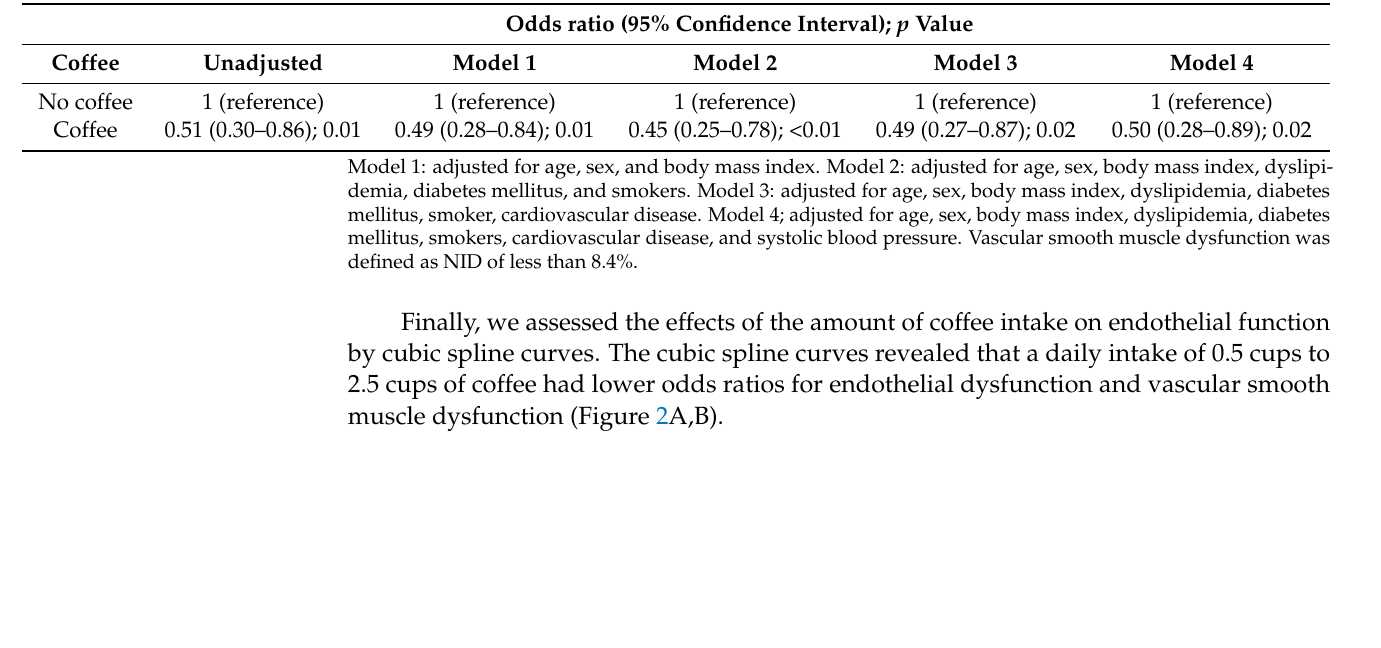
Table 3. Multivariate Analysis of Vascular Smooth Muscle Dysfunction in No Coffee and Coffee Groups.